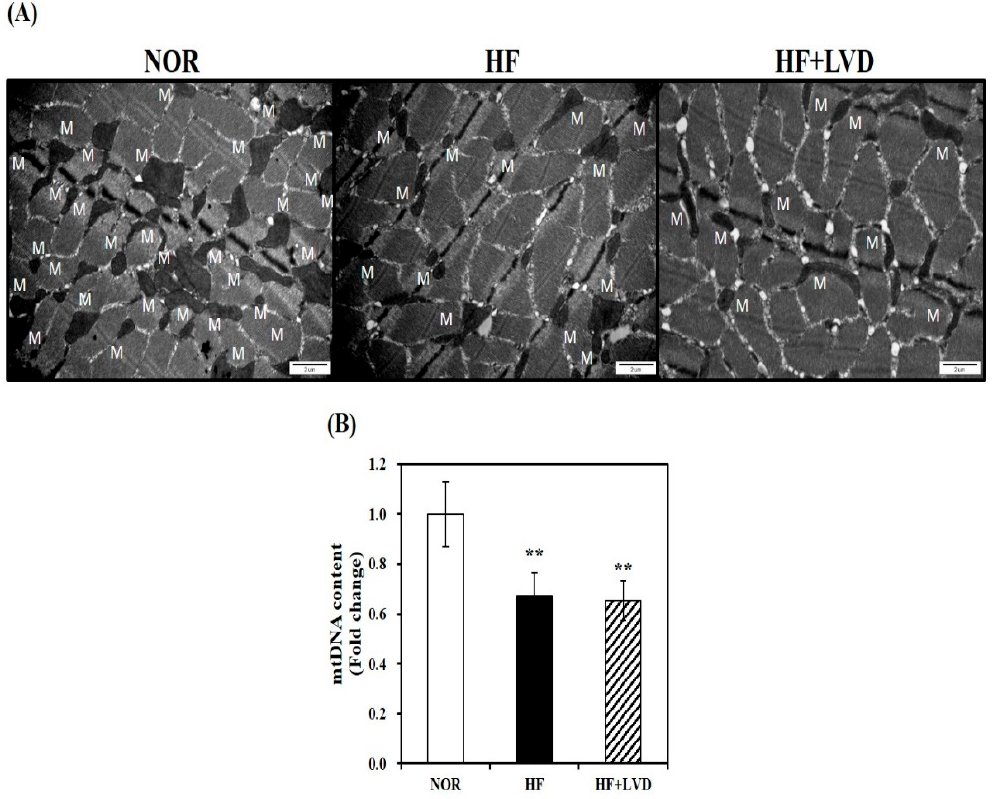
Figure 3. Mitochondrial morphology and mitochondrial DNA (mtDNA) contents in skeletal muscle fed with either vitamin D-adequate or insufficient diet for 12 weeks. ( A ) Electron microscopy of muscle (magnification of 20,000; scale bars = 2 μ m). M indicates the position of mitochondria. The mtDNA contents were quantified by qRT-PCR ( B ). Values are expressed as mean ± SEM ( n = 7–9 per group). ** p < 0.01 compared to NOR. NOR, 10% fat diet with 1000 IU vitamin D; HF, 45% fat diet with 1000 IU vitamin D; HF + LVD, 45% fat diet containing 25 IU vitamin D.